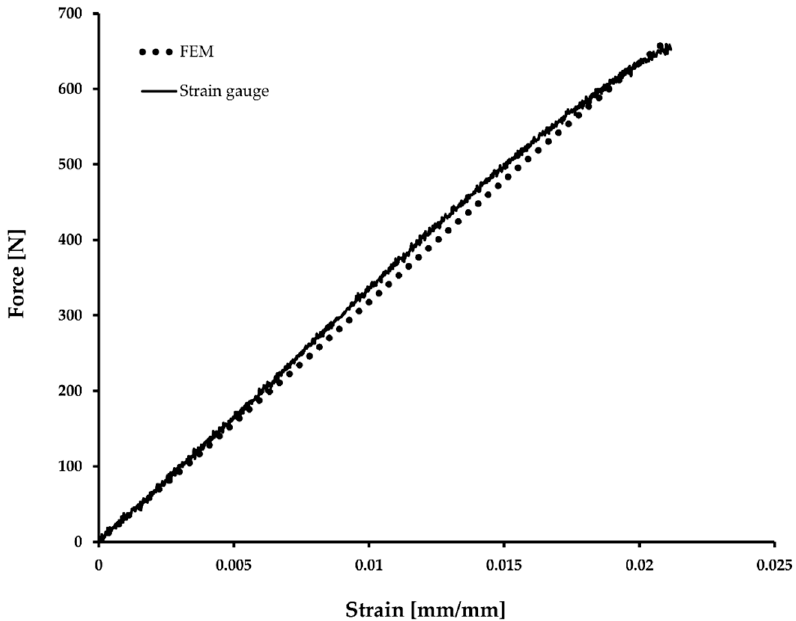
Figure 8. Three point bending response using finite element method and experimental mechanics.